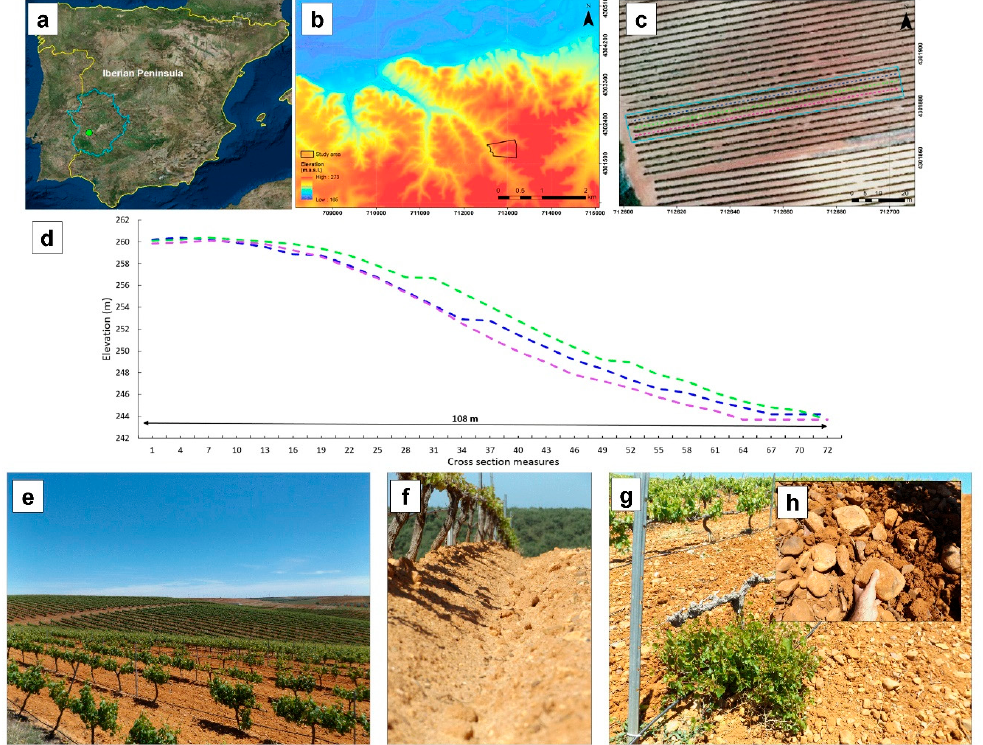
Figure 1. Location of the study area ( a ), topographical changes ( b – e ) and soils ( f – h ).